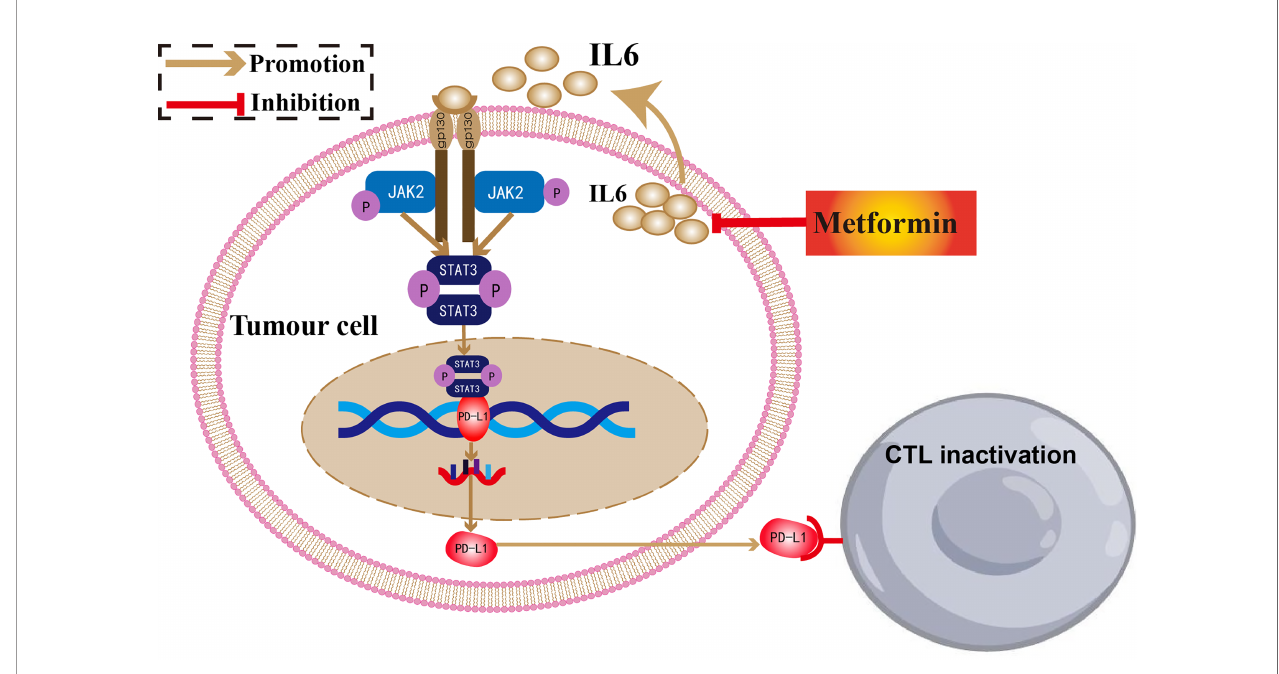
FIGURE 7 | The antitumor mechanism of metformin in